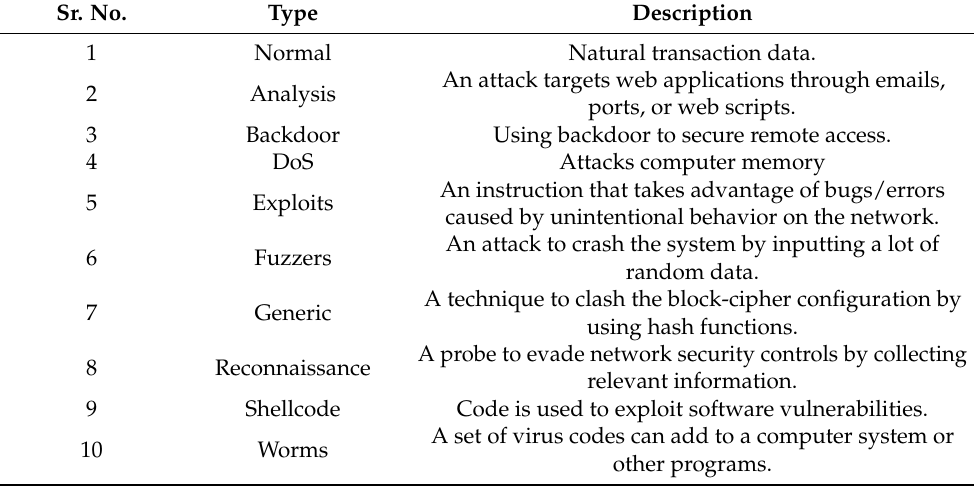
Table 1. UNSW-NB 15 dataset categories.